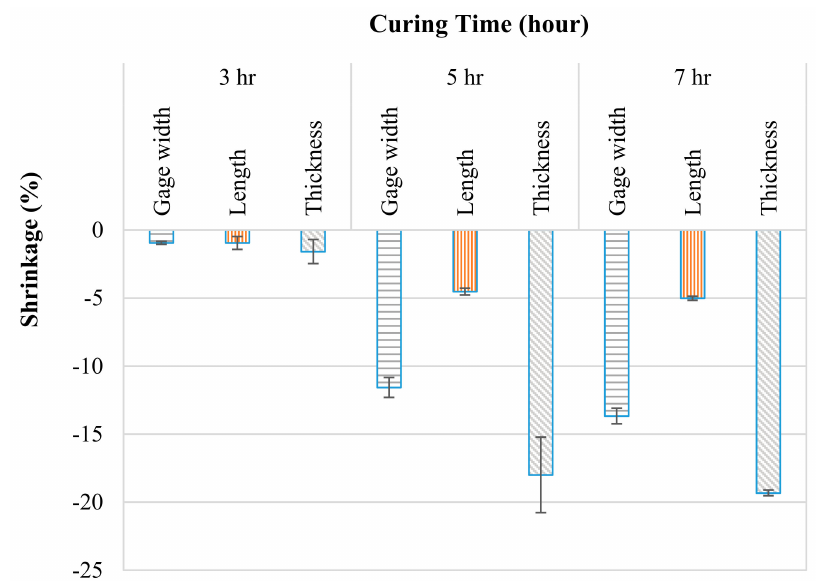
Figure 10. Breakdown of curing shrinkage in di ff erent directions when cured for various times.